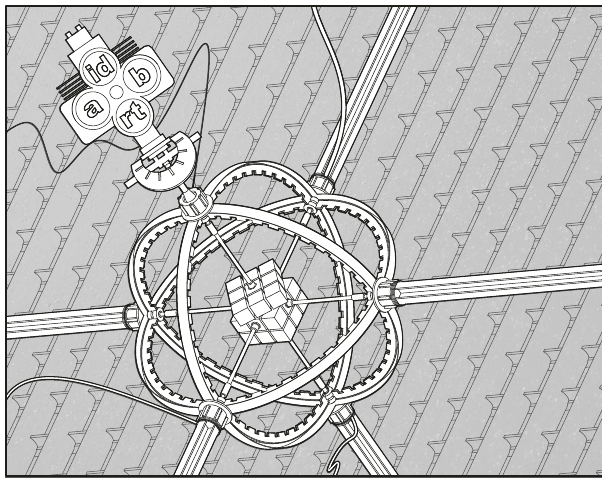
Fig. 1 A noisy Rubik cube solver as an example of a probabilistic fi nite automaton (PFA). This PFA has as many states as different Rubik cube con fi gurations. It begins in some prede fi ned state and can be manipulated with four different buttons or input alphabet symbols: { a , b , id, rt}. A Rubik cube can be solved by combinations of only two sequences of rotations 36